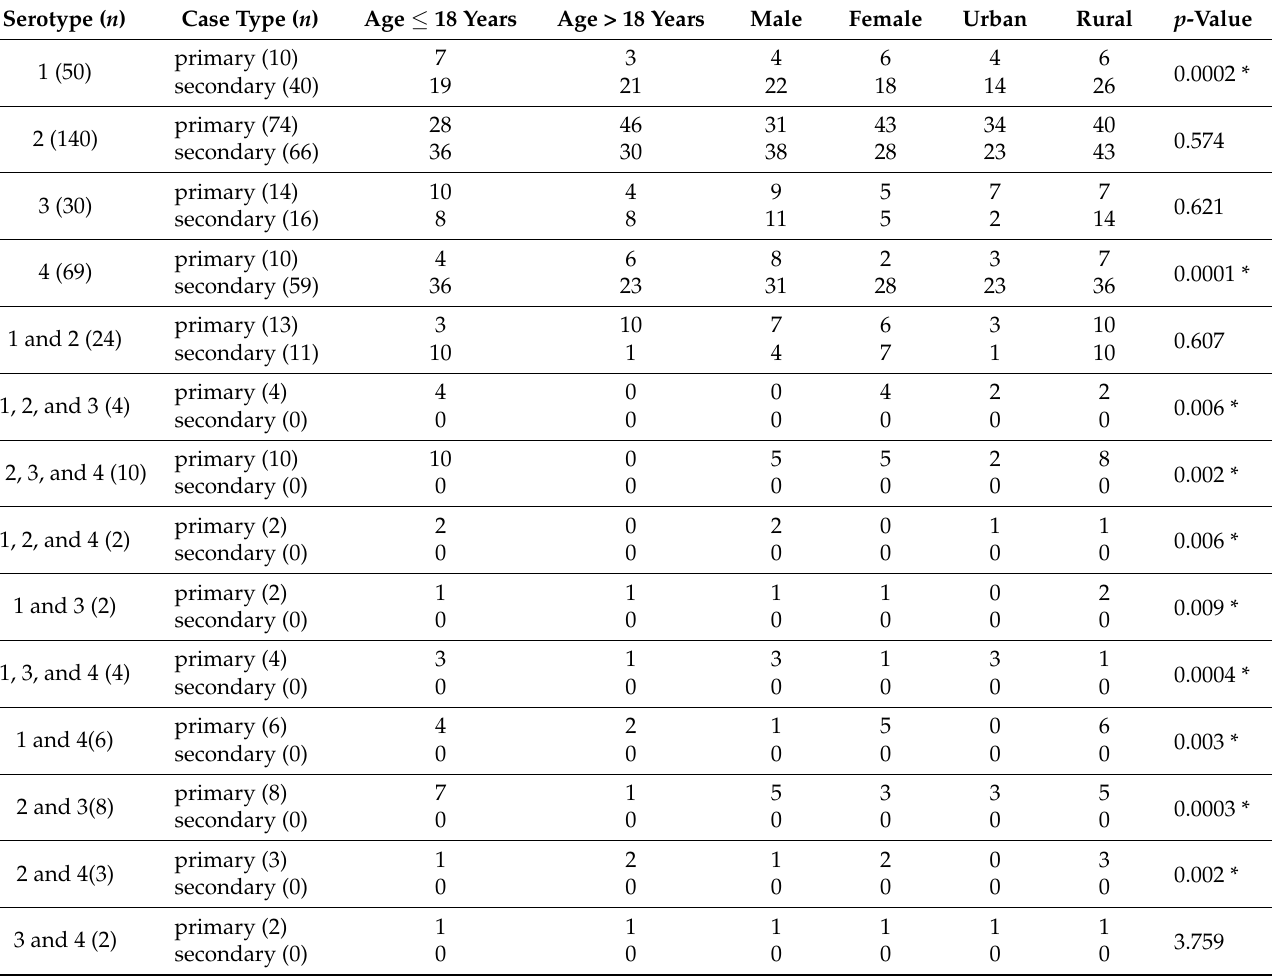
Table 2. Distribution of dengue serotypes in primary and secondary dengue cases and socio- demographic